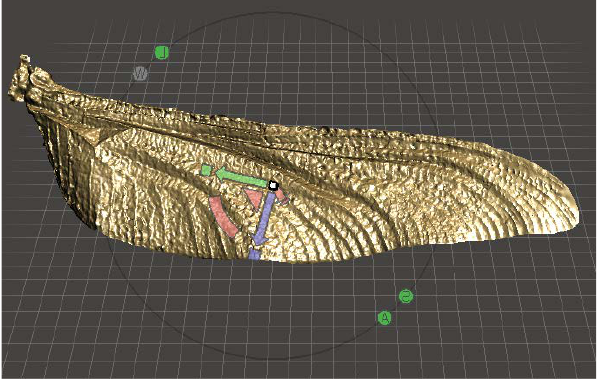
Figure 3. Three dimensional reconstructed of a Petalura Ingentissima hindwing.